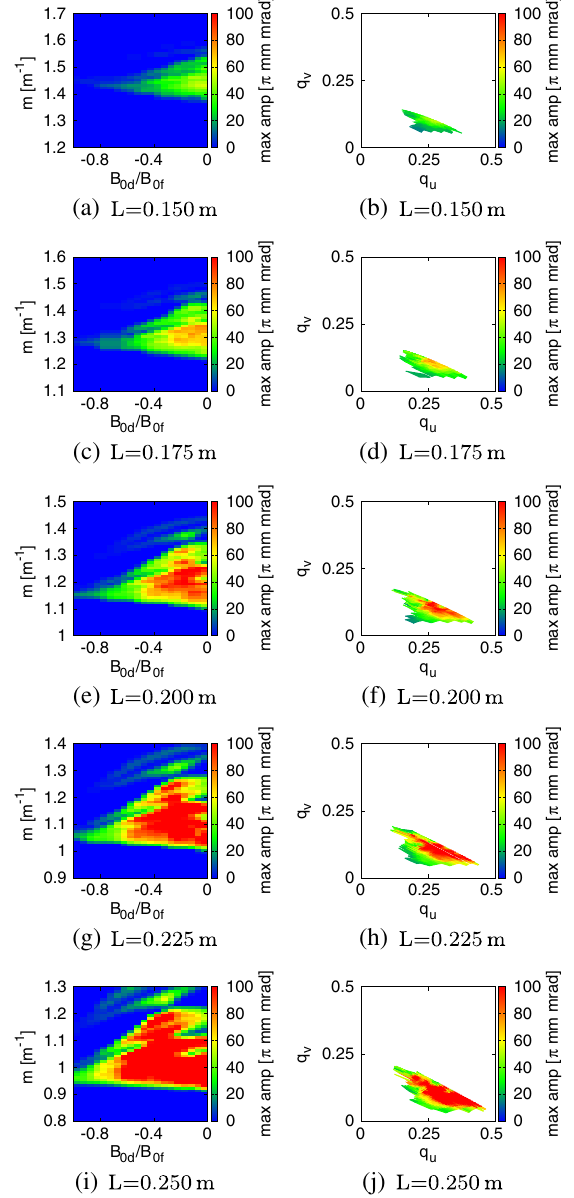
=B 0 space(a,c,e,g,i)andin q d f